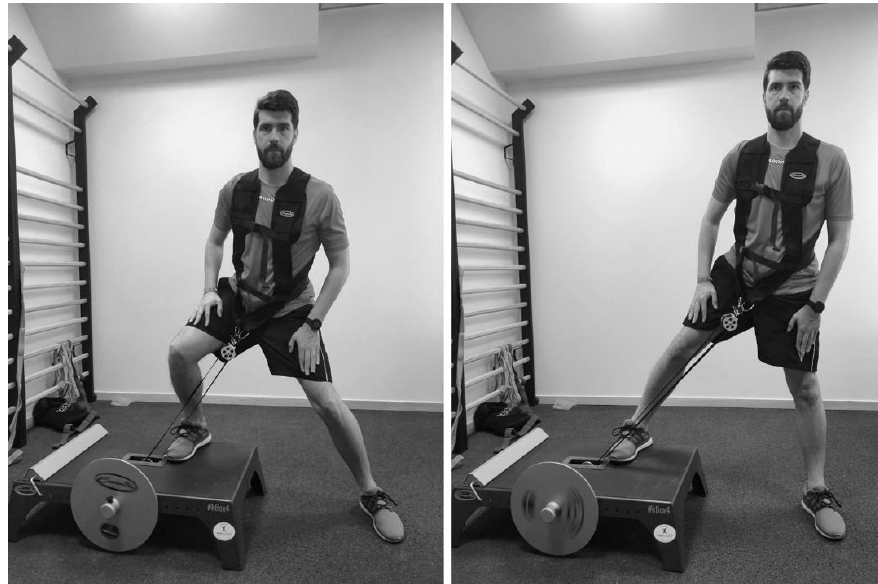
Figure 2. Lateral-squat exercise performed in the study.